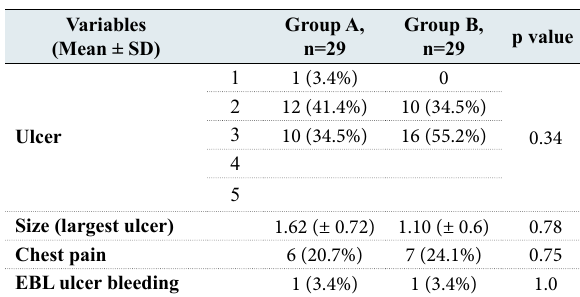
Table 2 : Upper GI endoscopic findings on follow up at the end of two weeks